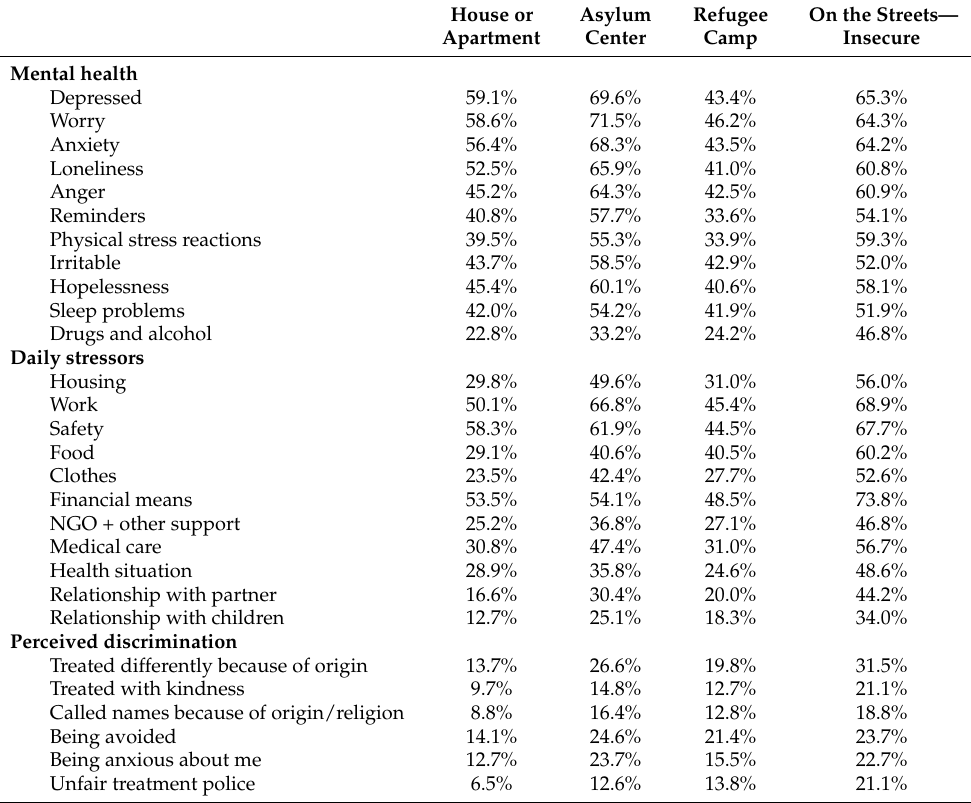
Table 3. Percentage of respondents reporting a deterioration in their condition in relation to hous- ing